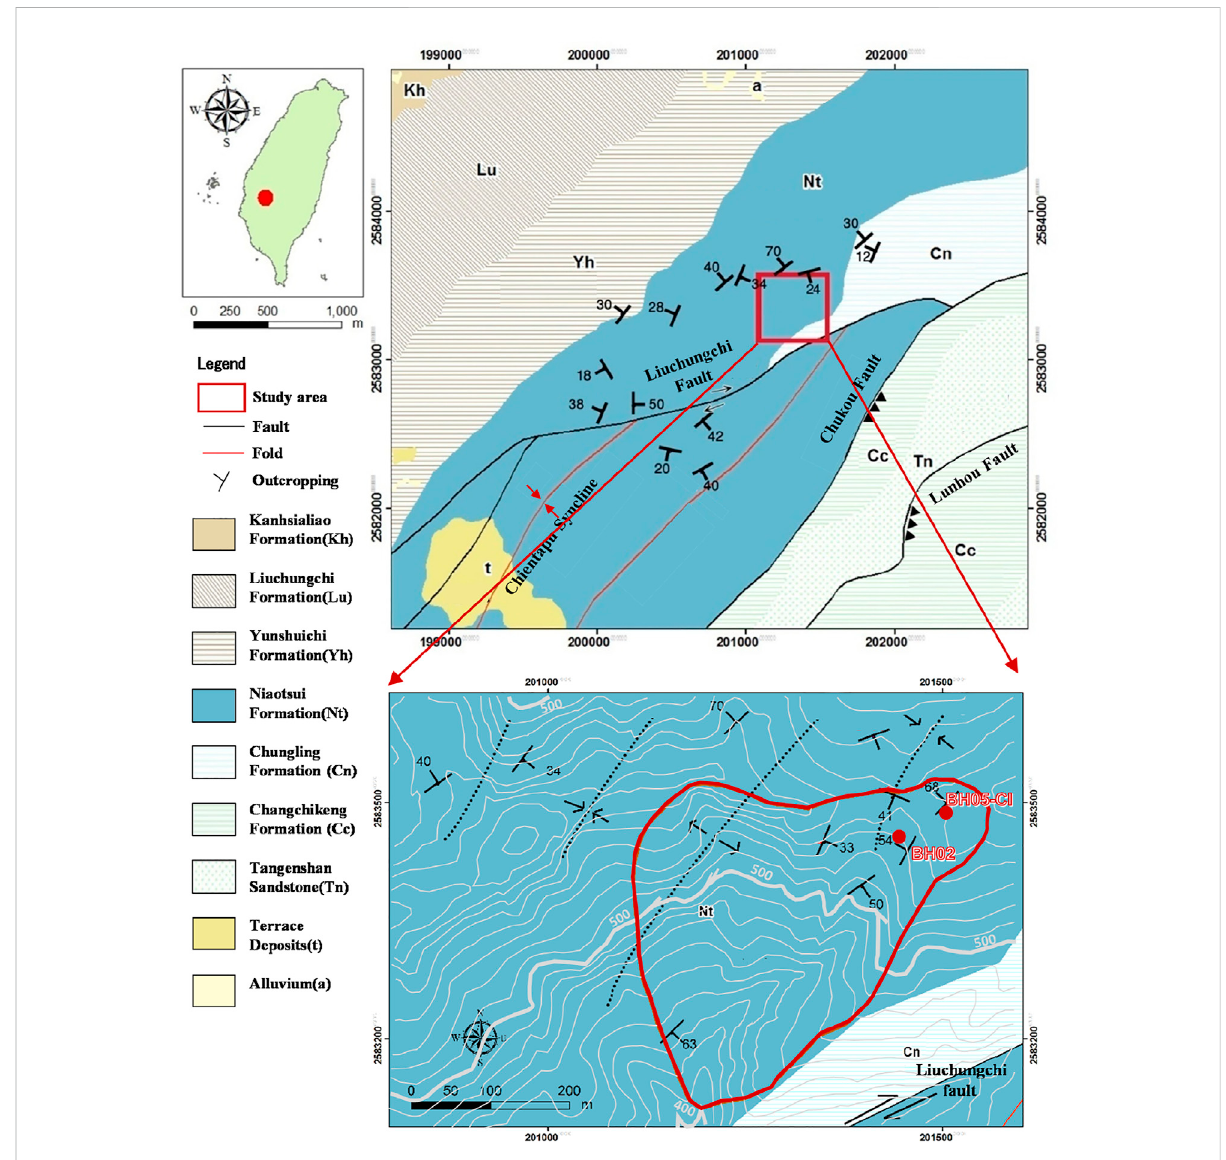
FIGURE 2 Schematic diagram of geology and geological structure in Babaoliao